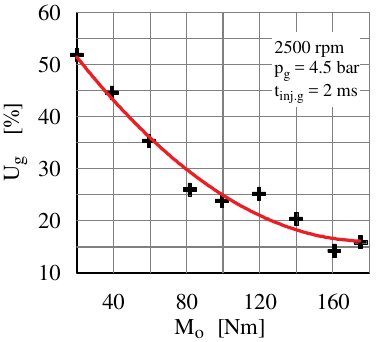
Fig. 5. Changes of gas energy share depending on engine load by fueling with diesel oil and dual fuel: gas injectors opening times 2 ms, fixed gas supply pressure 4.5